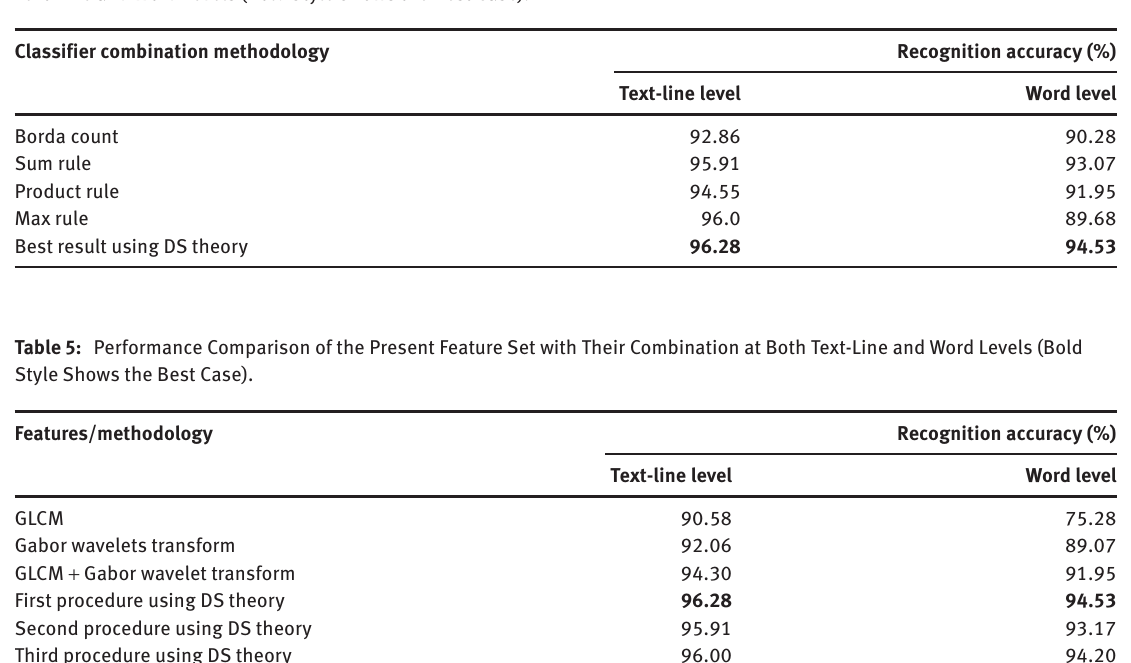
Table 4 records the accuracy obtained at the at both the text-line level and word level script data by these procedures.